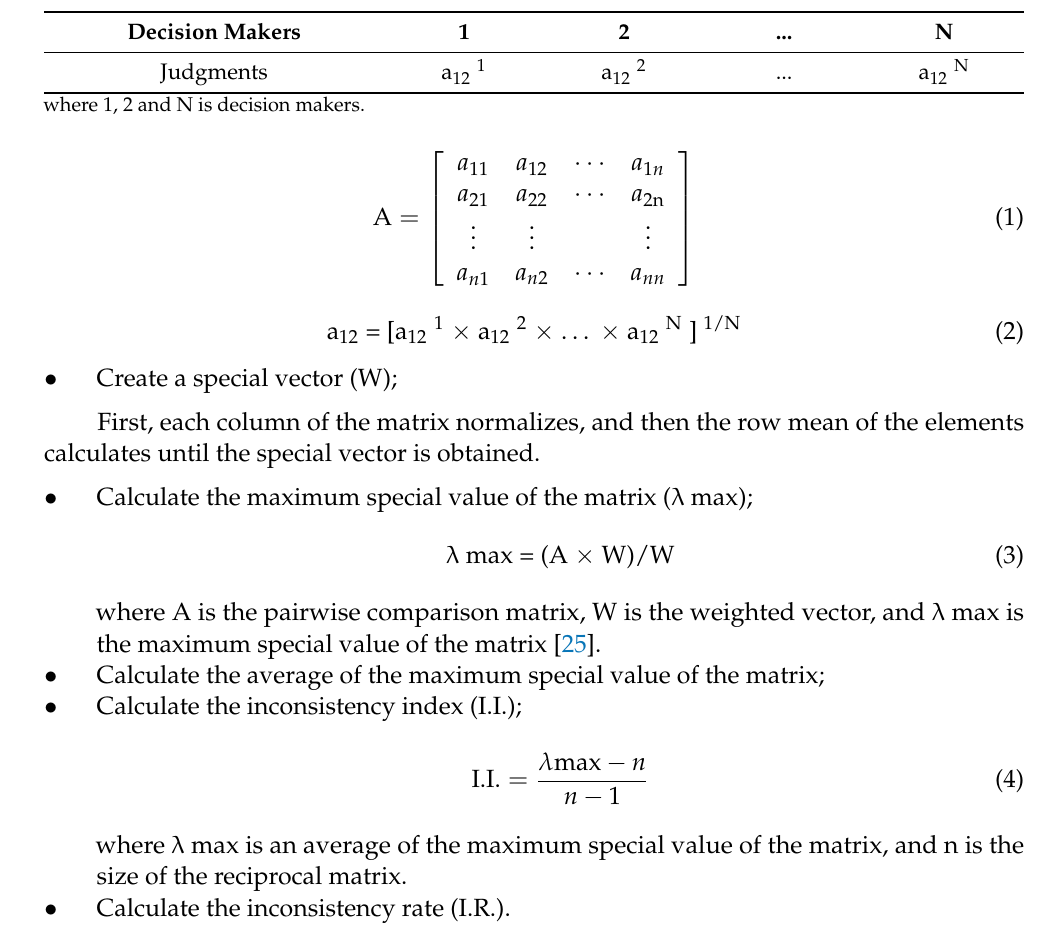
Table 1. Professional judgments.